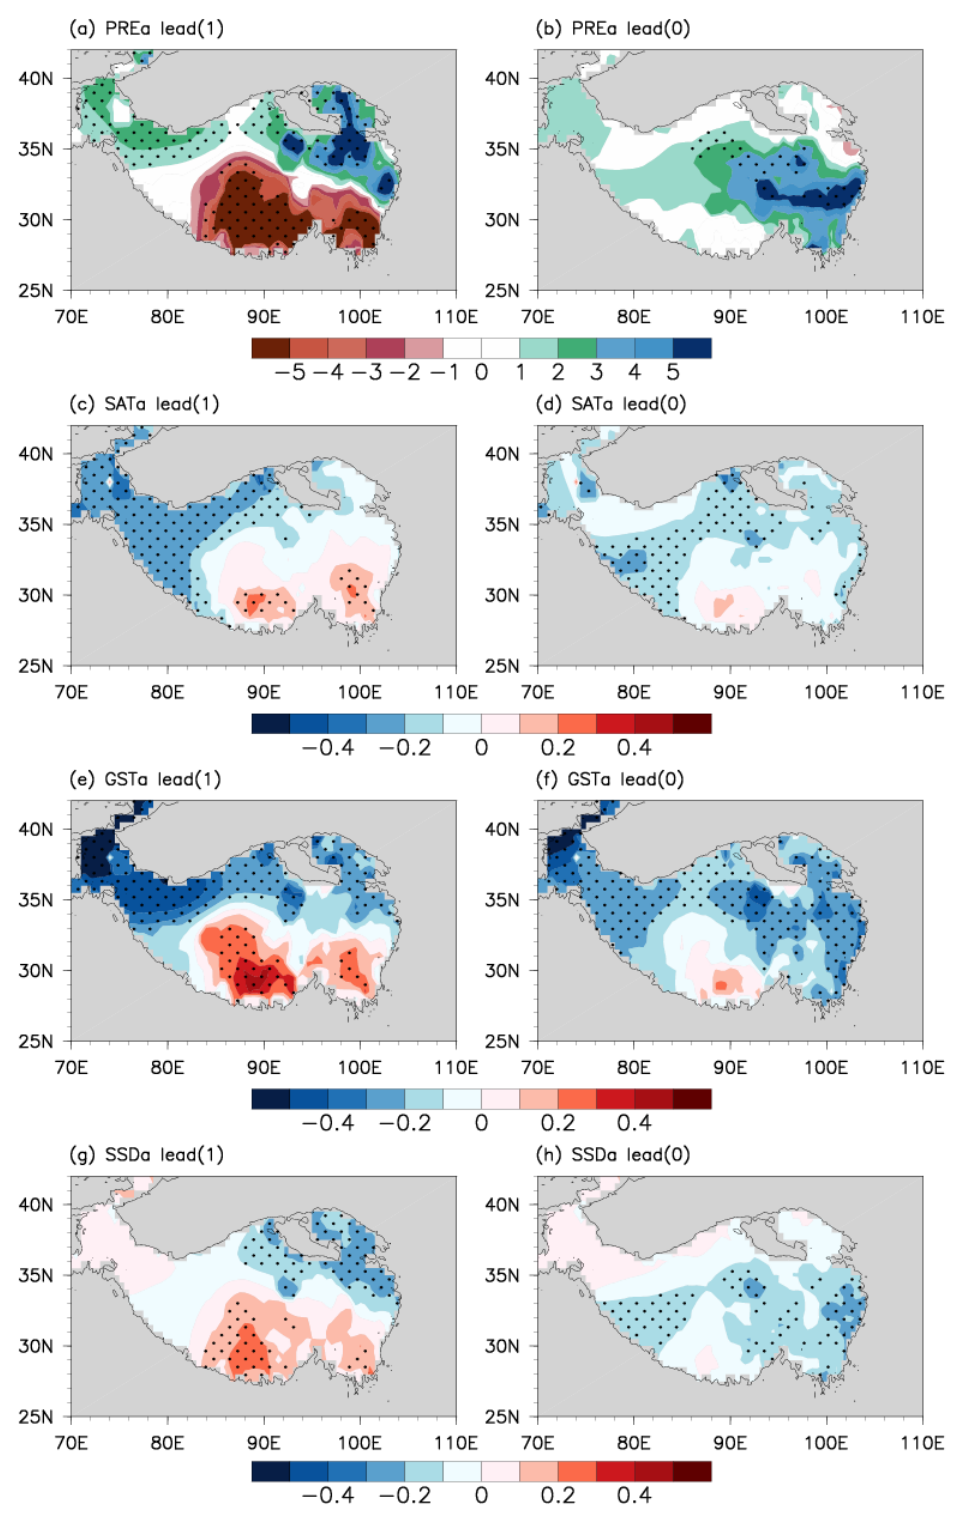
Figure 6. MJJA PRE ( a ; unit: mm), SAT ( c ; unit: °C), GST ( e ; unit: °C), and SSD ( g ; unit: hours) anomalies regressed upon the JJAS DNI for the period 1982–2020. Lead (1) denotes anomalous climatic factors that occurred one month earlier than the NDVI anomalies. ( b , d , f , h ) as in ( a , c , e , g ), but for anomalous climatic factors during JJAS. Lead (0) denotes anomalous climatic factors that occurred at the same time as the NDVI anomalies. Anomalies of climatic factors significant at the 95% confidence level are stippled with black dots.